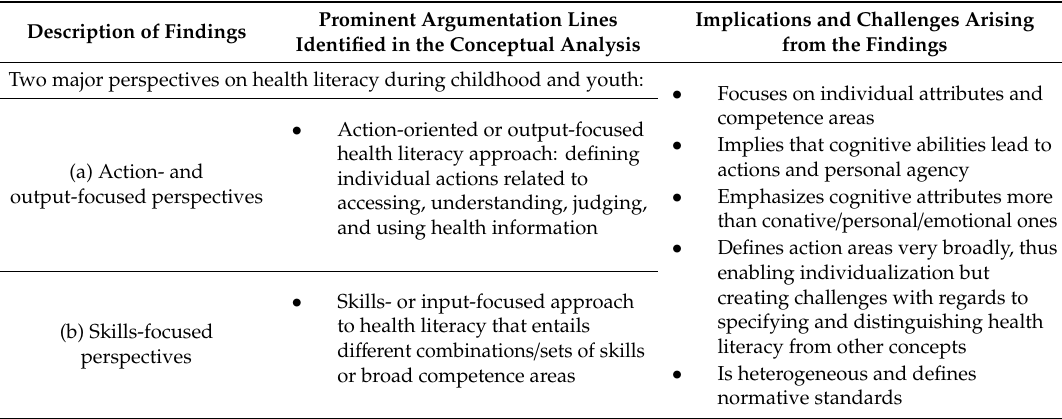
Table 3. Summary of conceptual reflections regarding health literacy content and